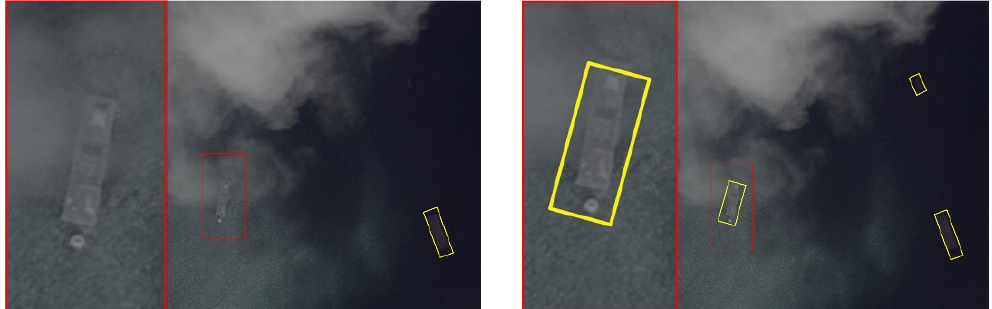
Figure 10. Detection results of ships with cloud and fog interferences on the images of the DOTA-GF dataset ( left : RetinaNet method; right : our proposed